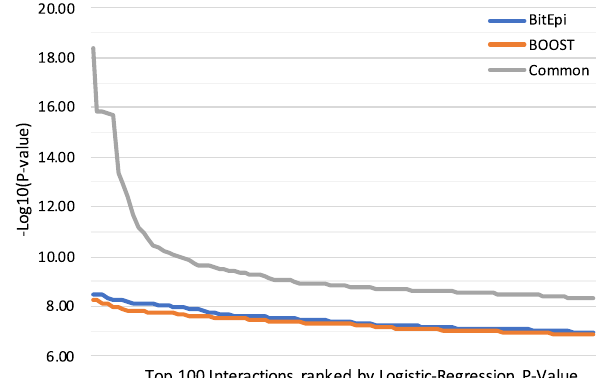
Figure 7. The figure shows the p -value of the identified interaction pairs, color-coded by being uniquely discovered by BitEpi, BOOST, or discovered by